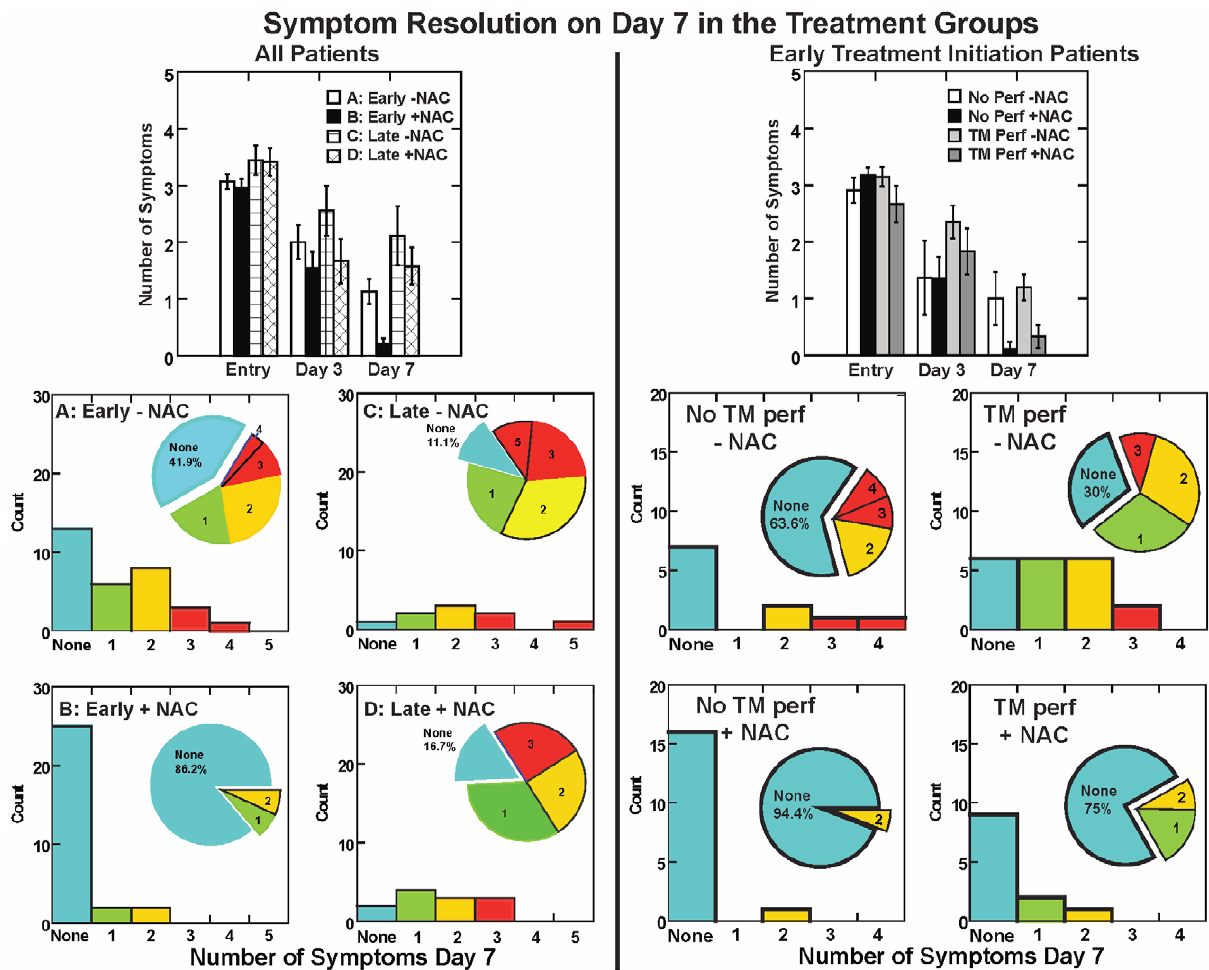
Figure 2. The number of symptoms for four groups of patients. The upper left panel shows results for all patients in the study. The upper right graph illustrates the impact of tympanic membrane perforations in the patients seen within 24 hours of blast exposure The distribution of the data on day 7 are shown for each group in the lower graphs, with a pie chart to indicate the percentage with no residual symptoms.